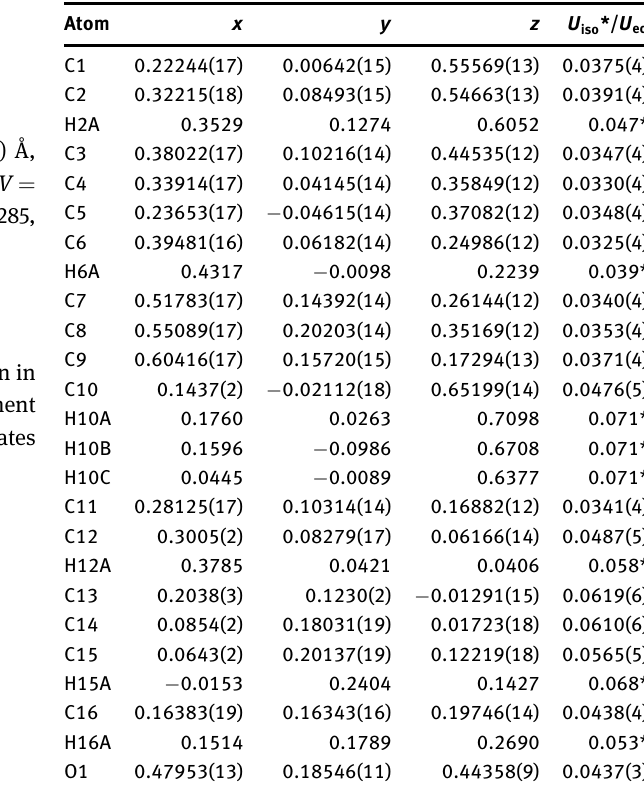
Table 2: Fractional atomic coordinates and isotropic or equivalent isotropic displacement parameters (Å 2